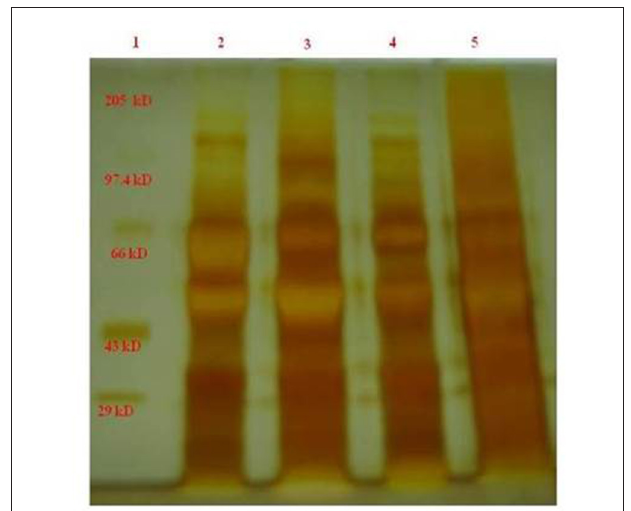
FIGURE 1 | The band around 55 kDa was less expressed in the case of asthenospermia, but present in the case of oligospermia, normospermia, and healthy volunteers. We guessed the importance of missed 55-kDa protein and further we want to investigate on this protein. GelAnalyzer was used to analyze this 1D SDS PAGE bands and all the interpretation has been done by the standard protocol. 1, marker standard; 2, Normospermia; 3, healthy volunteer; 4, Asthenospermia; 5,